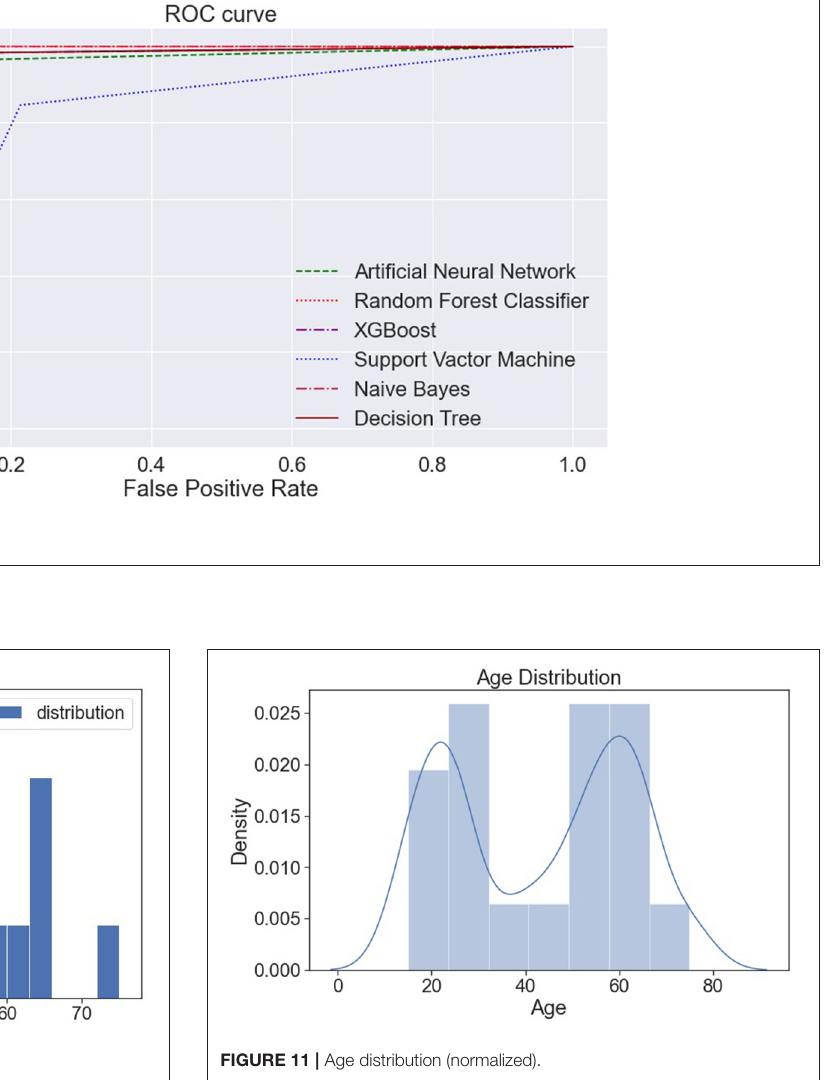
FIGURE 10 | Age-wise distribution.